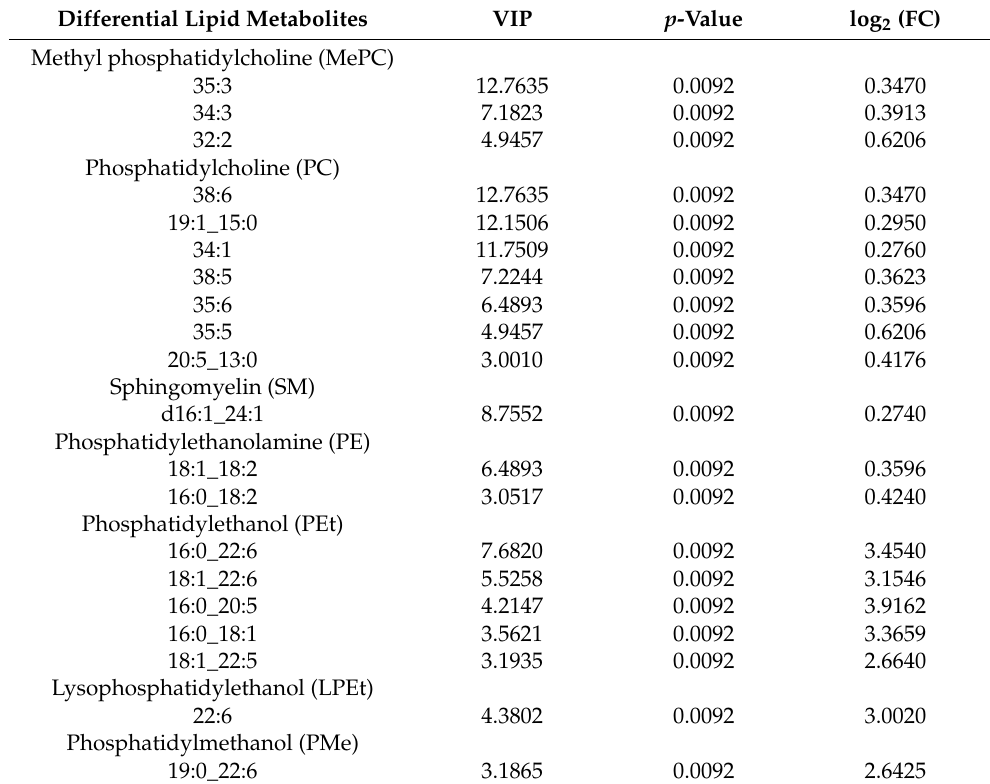
Table 5. The differential lipid metabolites in the liver of juvenile American eels in the PSPc0 group and PSPc900 group.